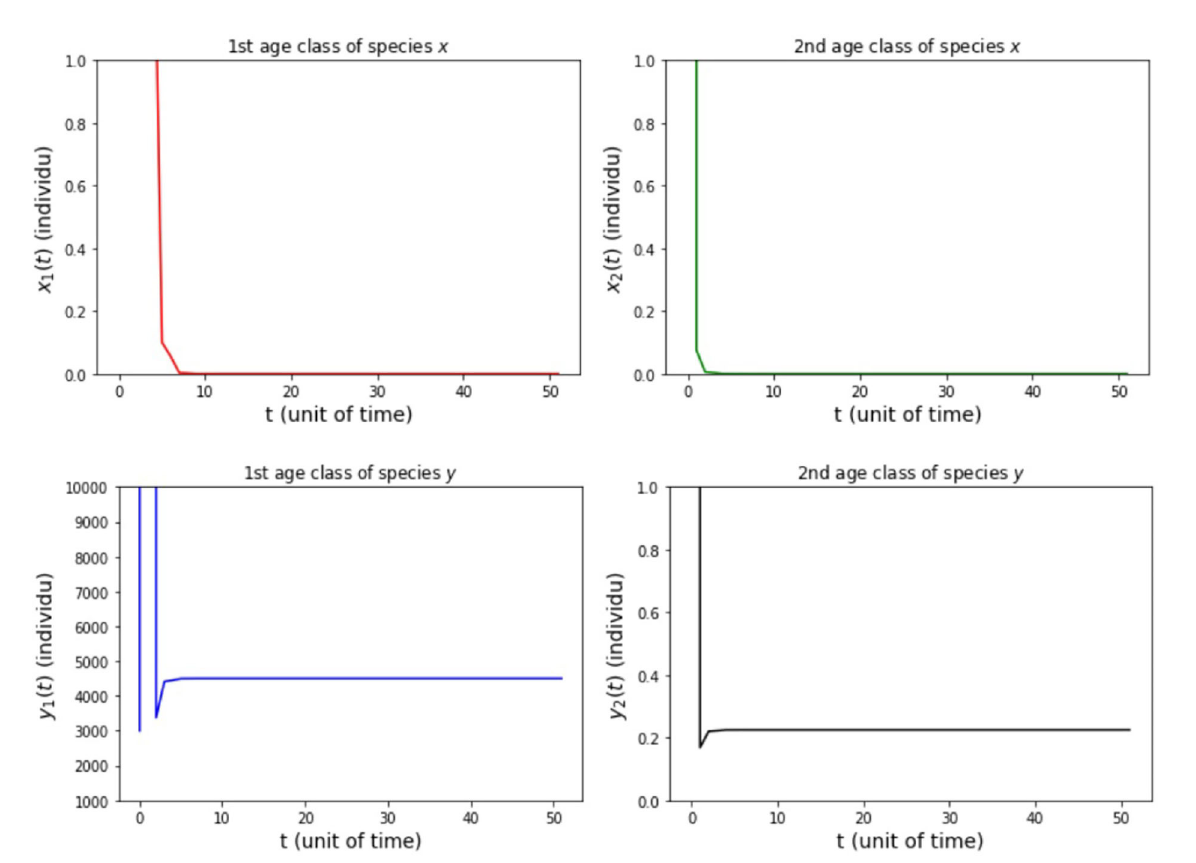
FIGURE4 Population growth of each age class from case (iii) Model